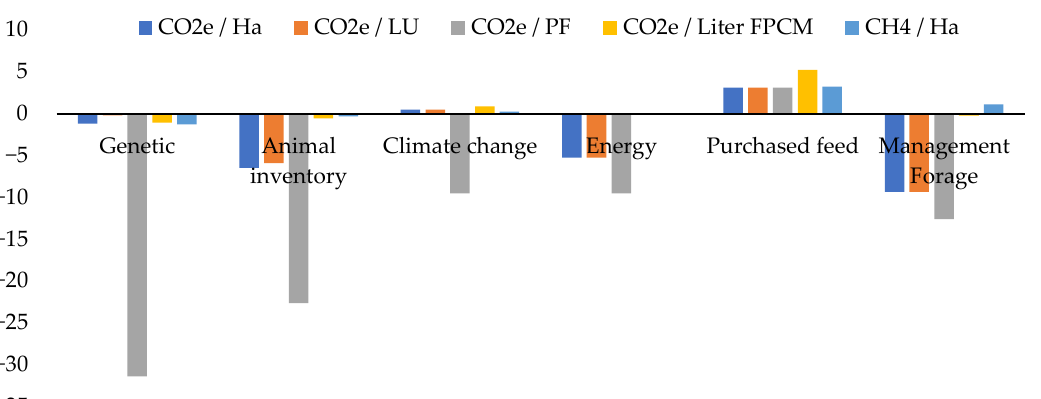
Figure 2. Simulated strategies: changes among groups in terms of the average percentage of